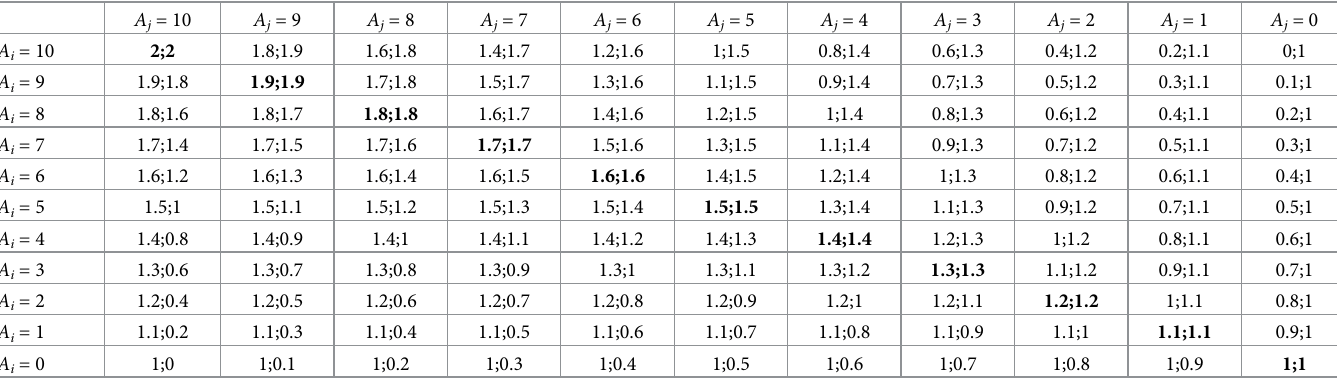
Table 1. Payoff matrix for complementary production, with ω i = ω j = 0.8.